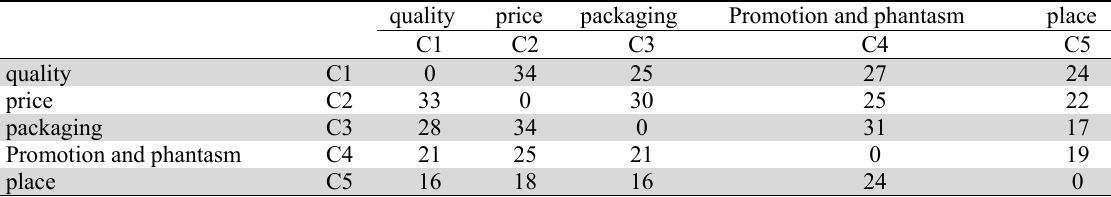
The total answer matrices